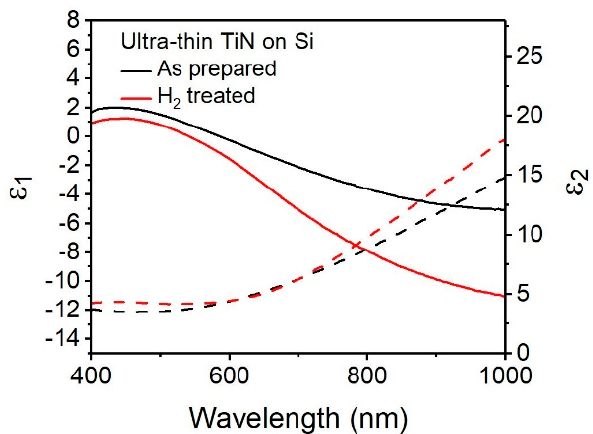
Figure 5. Real (solid line) and imaginary (dashed line) values of permittivity for ultra-thin TiN on Si <100> substrate as prepared (black) and after hydrogen plasma treatment (red).